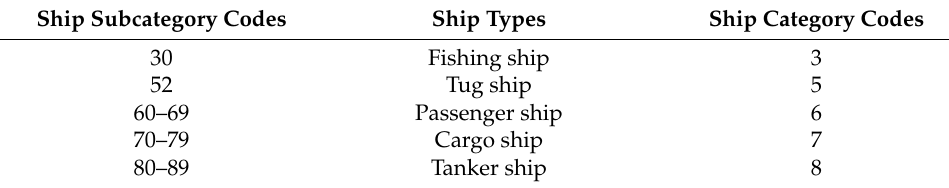
Table 2. The corresponding relationships between AIS ship type codes and ship types.